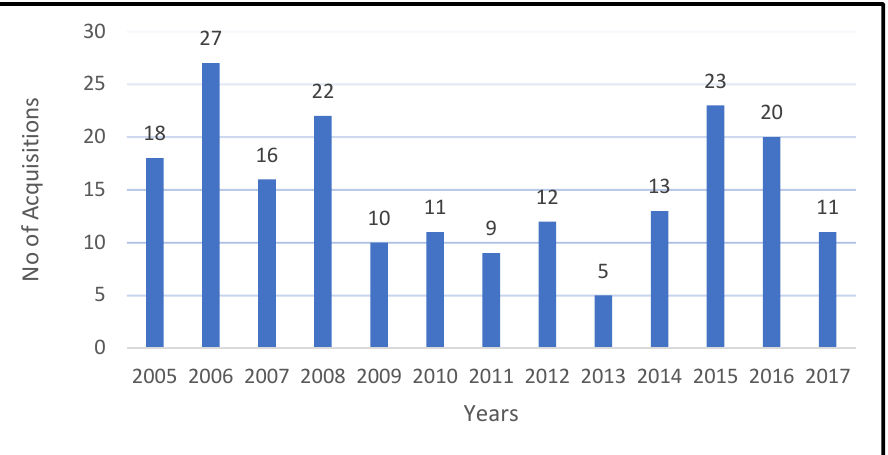
Figure 2. CBA by Indian pharmaceutical firms from January 2005 to December 2017. Source: Compiled from CMIE Prowess IQ database.